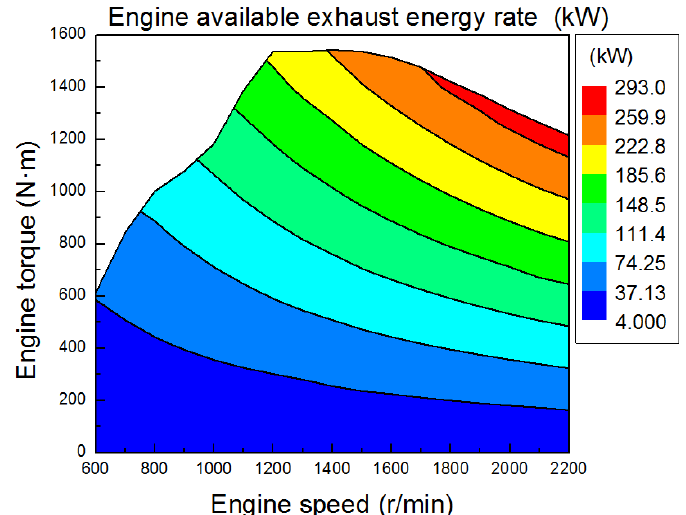
Figure 3. Engine available exhaust energy